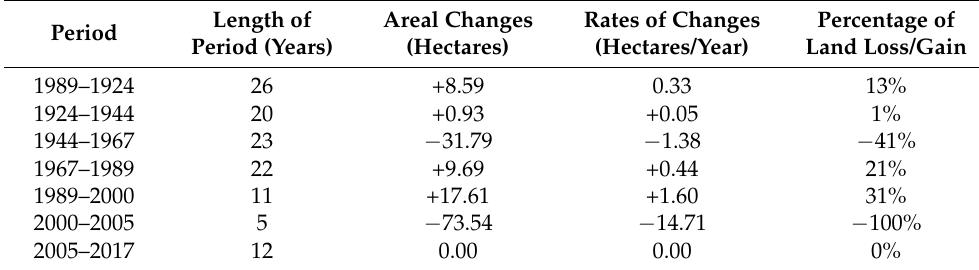
Table 3. Average long-term historical rates of land area change for both coasts for selected periods at Lambadeuk. Rates are in hectares/year. Positive numbers indicate land gain, and negative numbers indicate a land